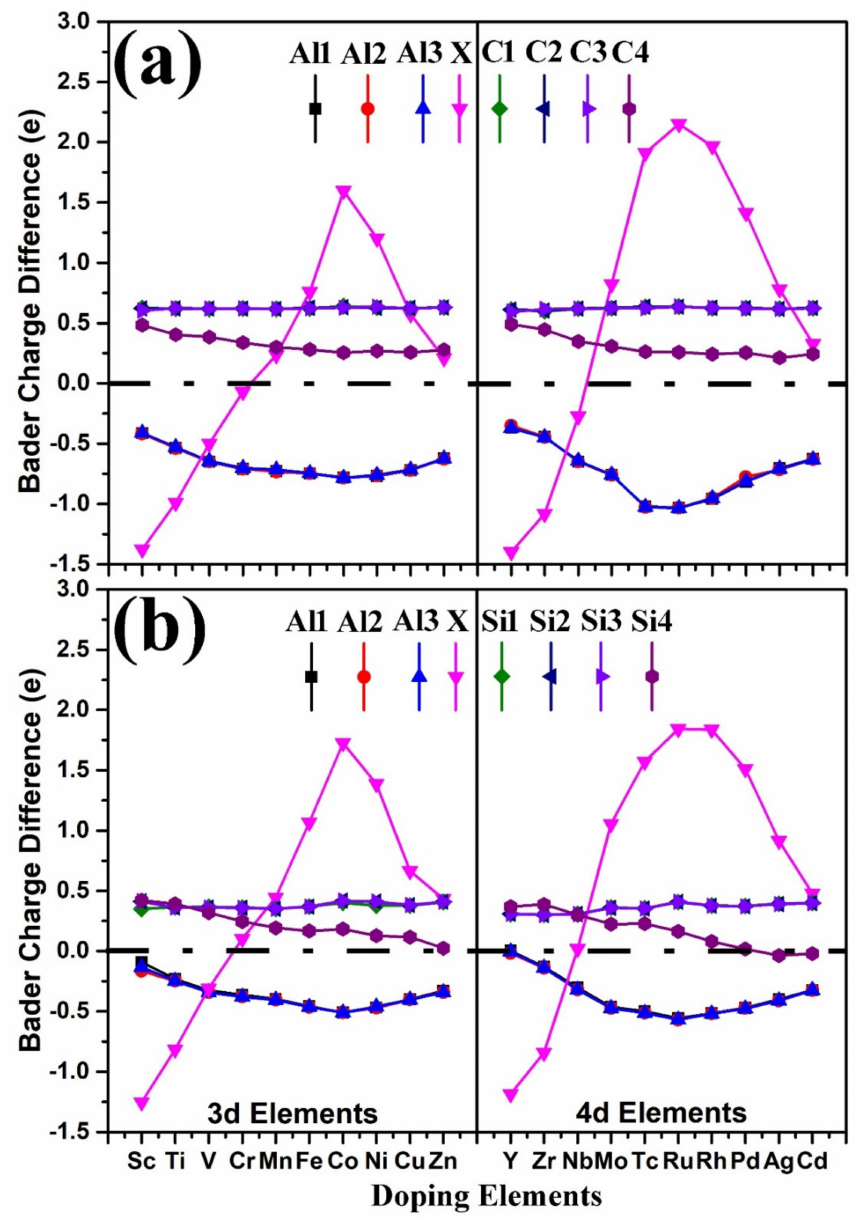
Figure 5. Bader charge difference of each atom at the Al-X(111)/6H-SiC(0001) interface. The positive and negative values represent the gain and loss of charges, respectively. The serial numbers of the eight atoms at the interface are the same as those in Figure 1. ( a ) the C-terminated interface; ( b ) the Si-terminated